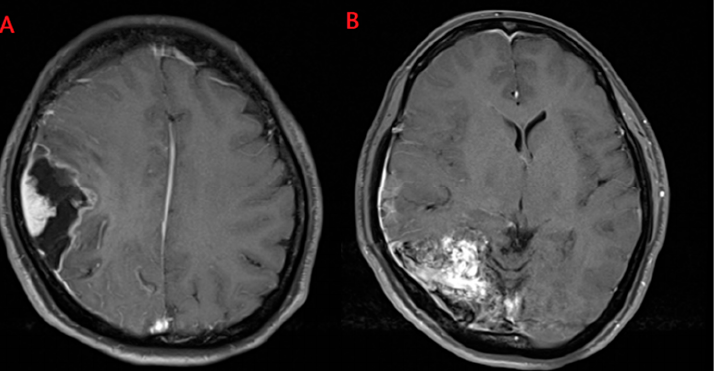
Figure 2. Magnetic resonance imaging scans. ( A ) Heterogeneously enhanced mass, 1.1 cm × 2.3 cm in size, with perifocal edema in the right temporal lobe was noted; ( B ) Surrounding and tangled dilated vessels in the right temporo-occipital area were observed on T1-weighted images with gad- olinium.